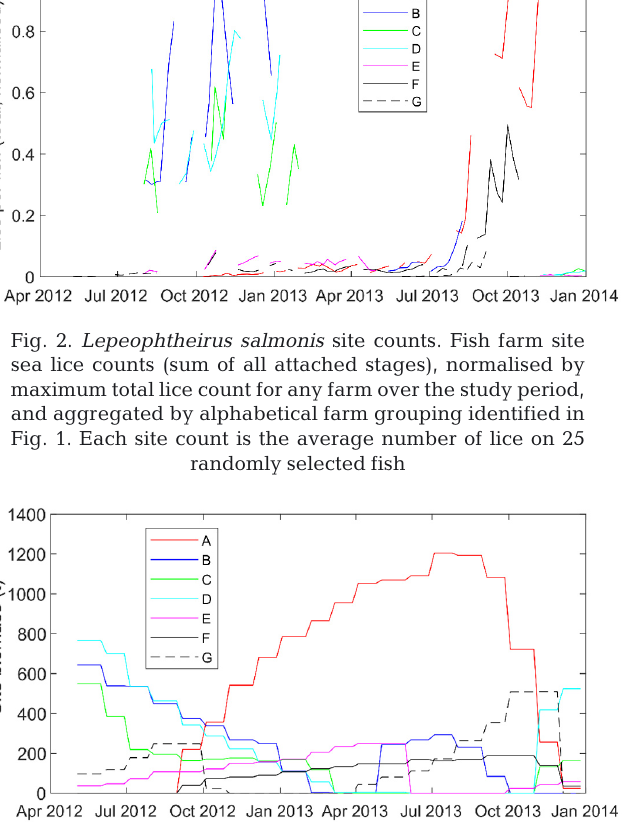
Fig. 3. Stocked site biomass of salmon Salmo salar over the study period, for all site groupings within the model domain (alphabetical IDs relate to Fig.